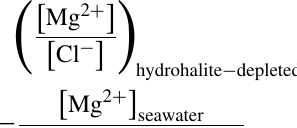
Figure 5. Variations of (a) concentration factor of Na + (CF Na ) and (b) molar ratios of SO 2 − The red line indicates the bulk seawater ratio. Error bars indicate standard deviation (1 σ ) of analytical